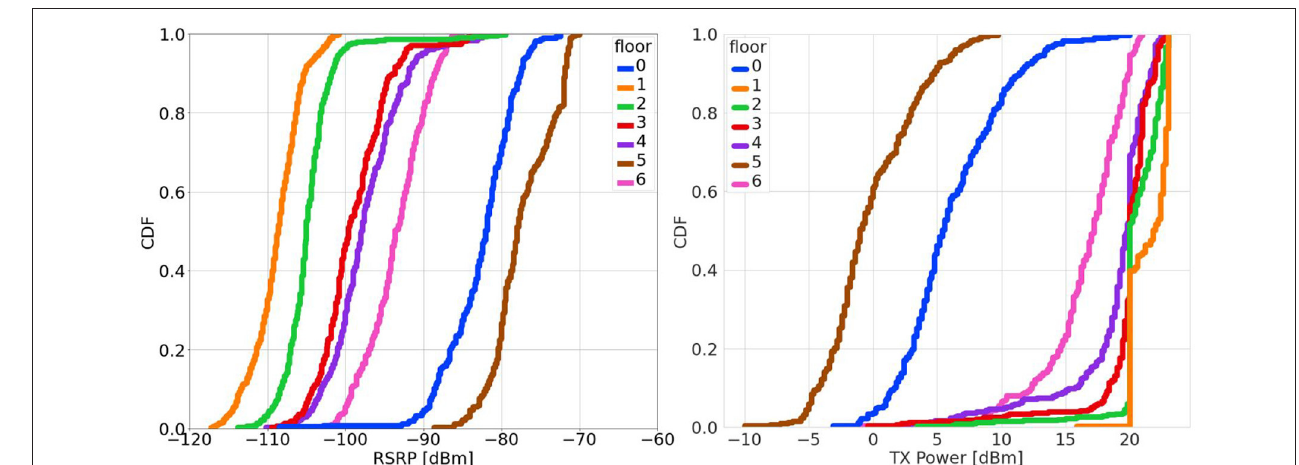
Frontiers in Public Health |